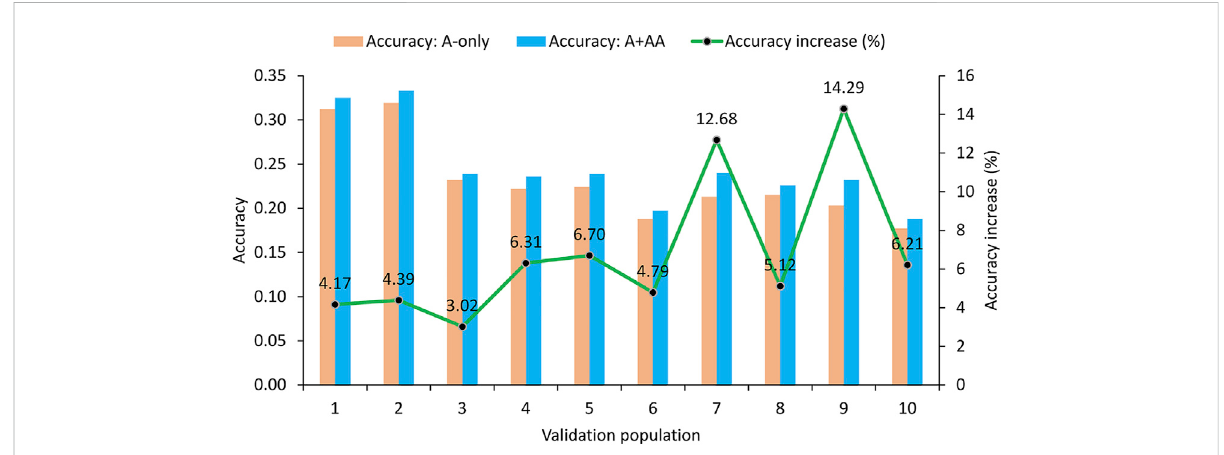
FIGURE 1 Accuracy of predicting RFI phenotypic values form 10-fold validation studies using 6215 Holstein